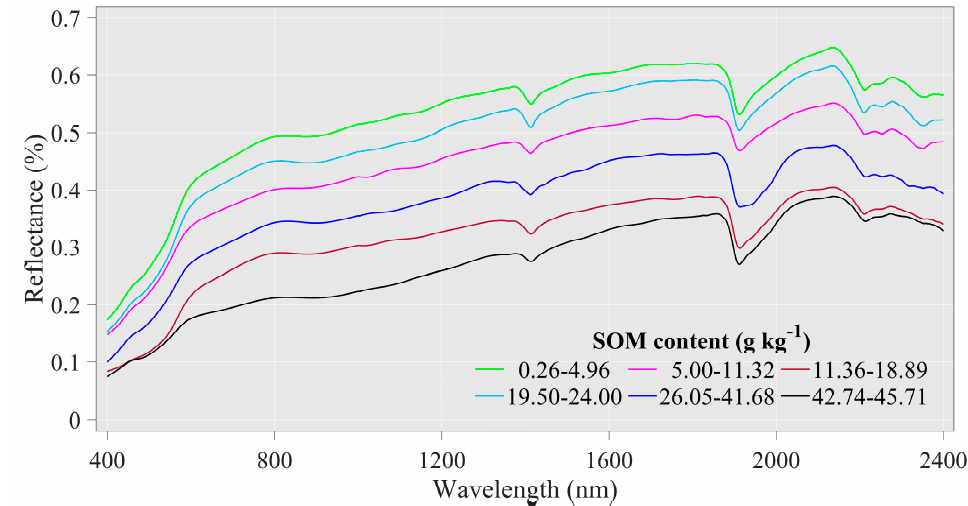
Figure 3. Mean spectral signature of soil organic matter (SOM) content under different classes.